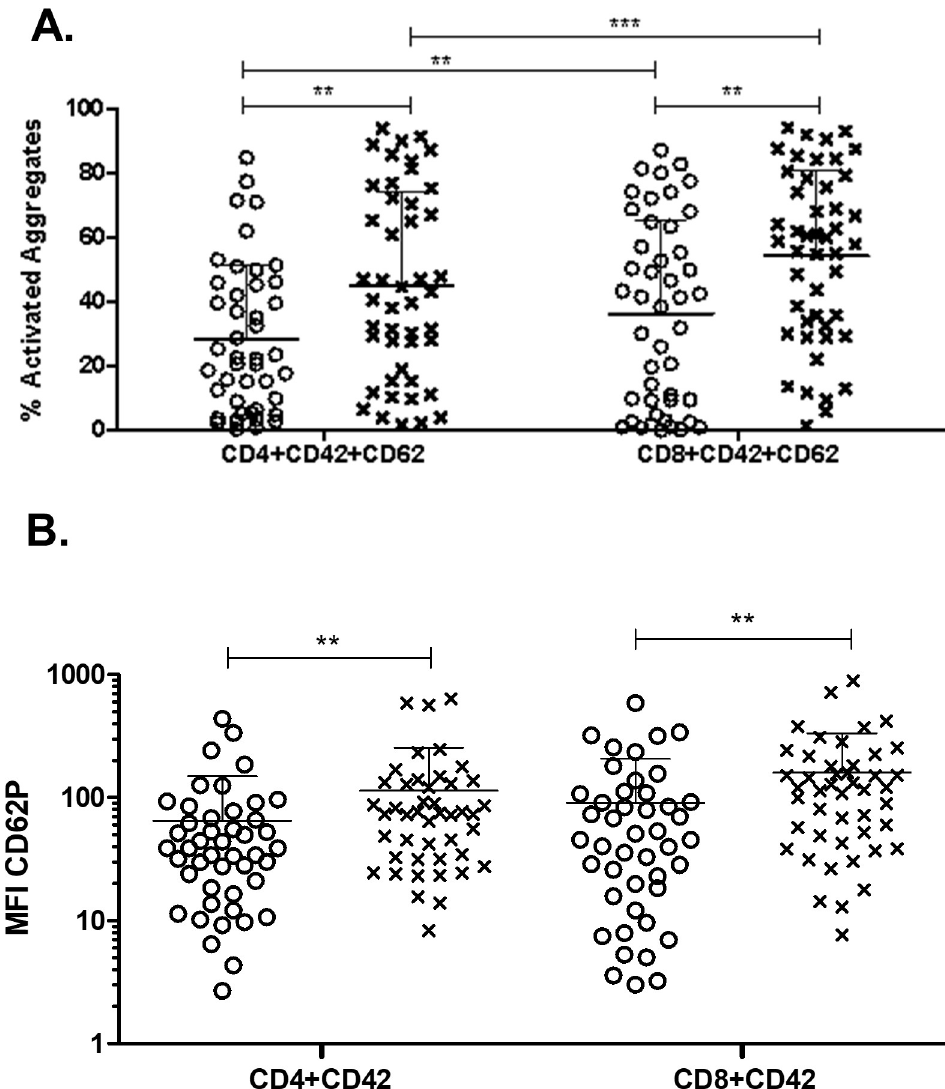
Fig 3. Platelet activation within platelet-T cell aggregates in lung cancer patients compared to healthy volunteers. Whole blood from healthy volunteers or lung cancer patients was labeled with markers for CD4+ T cells (anti-CD4) or CD8+ T cells (anti-CD8) and were co-labeled for platelets (anti-CD42b) and activated platelets (anti-CD62P, P- selectin). Data was collected by flow cytometry. Populations were gated based on CD4+ and CD8+. PTCAs were identified as in Fig 2. Populations were further gated based on PTCAs and the percent of activated platelets (A) and MFI of activated platelets (B) within PTCAs were calculated. Mann Whitney nonparametric test. Error bars represent mean ± SD. N = 44–52. �� p � 0.01, ��� p �